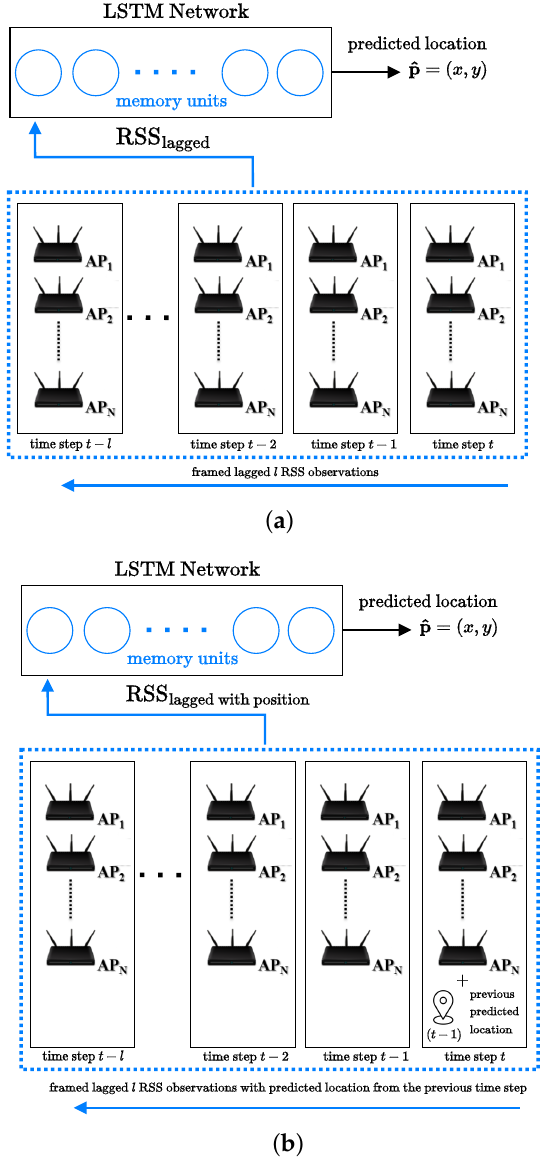
Figure 10. Two different proposed LSTM models. ( a ) Model 1: Lagged RSS observations as inputs. ( b ) Model 2: Lagged RSS observations with predicted location from the previous time step as